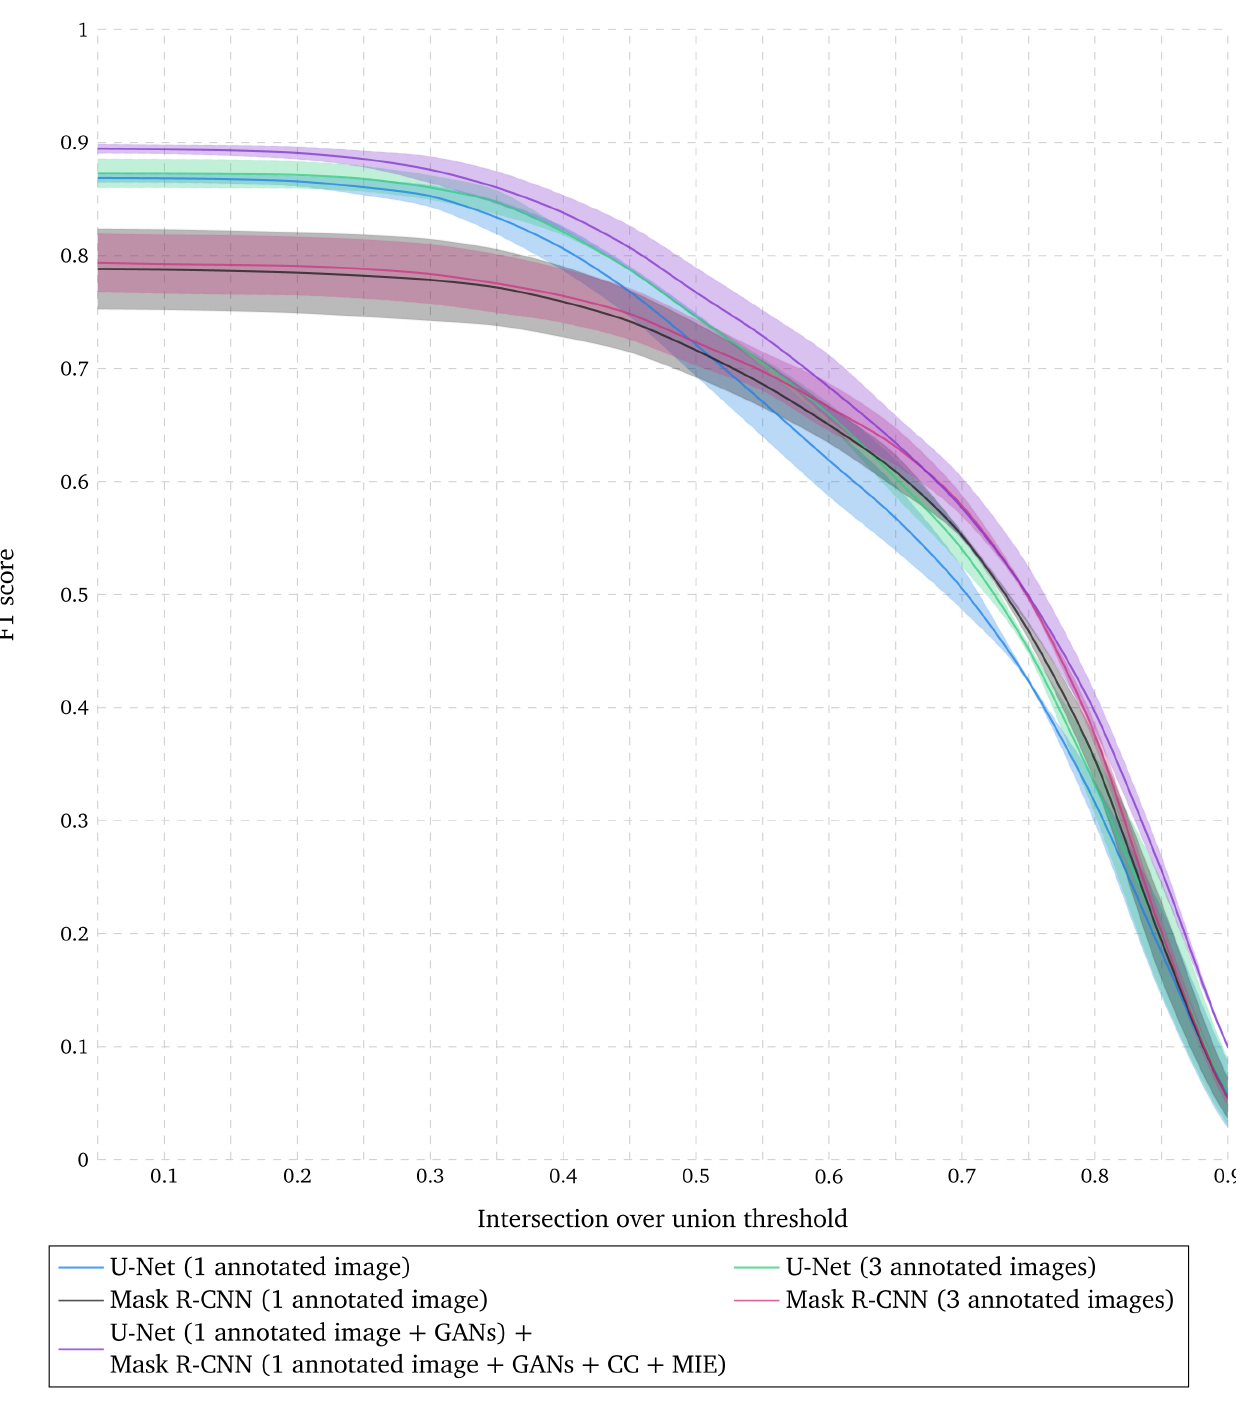
Figure 3. Evaluation of nuclear segmentation when combining U-Net and Mask R-CNN. F1 score for range of IoU thresholds obtained with U-Net trained with 1 and 3 annotated images with data augmentation (DA), Mask R-CNN trained with 1 and 3 annotated images with DA, and the combination of results obtained with U-Net trained with 1 annotated image with DA and augmented simulated images, and the results obtained with Mask R-CNN trained with 1 annotated image with DA, augmented simulated images and existing datasets with DA. Lines correspond to average F1 score over the two tested images while the shaded areas represent the standard deviation.